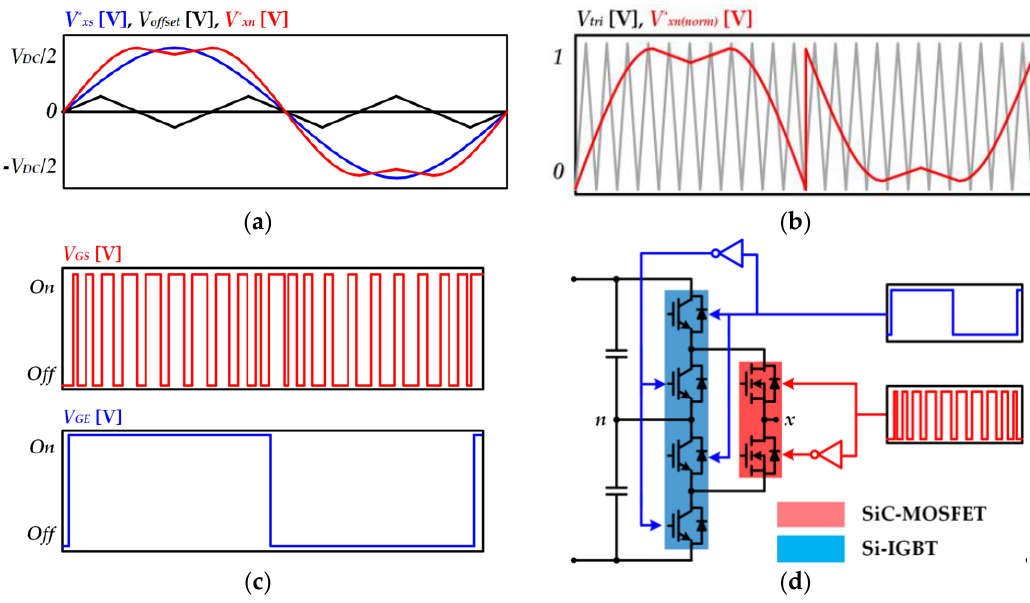
Figure 4. Operation principle of HANPC inverter: ( a ) reference voltages for space vector pulse width modulation (SVPWM); ( b ) normalized reference voltage; ( c ) PWM signals of high-speed frequency (HF) and low-speed frequency (LF); ( d ) gate signals for silicon-based insulated-gate bipolar transistors (Si-IGBTs) and silicon carbide metal-oxide-semiconductor field-effect transistors (SiC-MOSFETs) in HANPC inverter.